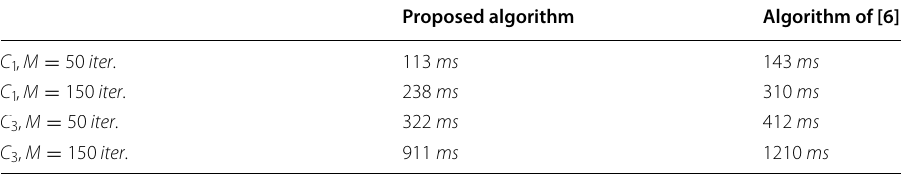
Table 2 Execution time of the proposed and existing algorithms Proposed algorithm Algorithm of